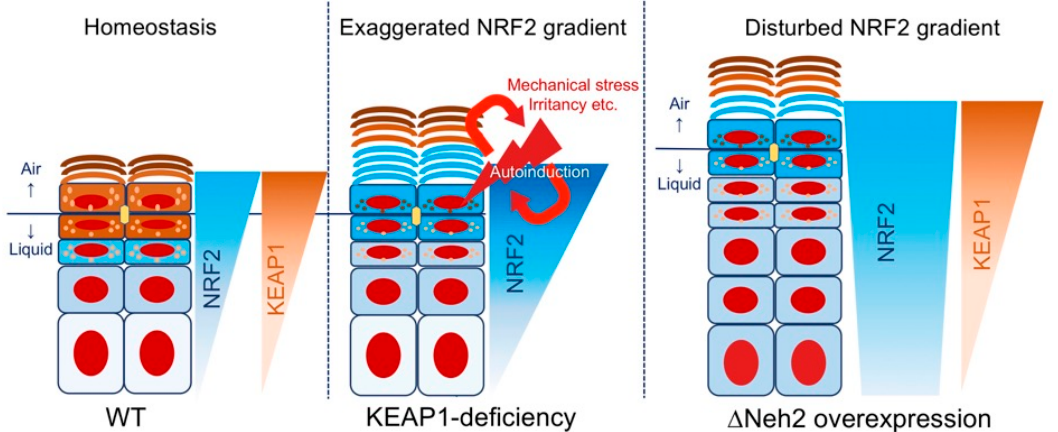
Figure 5. Why are Keap1 deficiency and Neh2 deficiency phenotypically different? Left: As with phase I detoxification, epidermal keratinocytes exhibit an incremented expression pattern of the KEAP1/NRF2 system that correlates with the degree of terminal differentiation. Middle: Absence of KEAP1 not only exaggerates the NRF2 expression gradient but also makes keratinocytes susceptible to cytoskeletal dysregulation (non-specific stimuli). Right: The overexpressed NRF2 that lacks the Neh2 degron augments NRF2 signaling in the presence of the inhibitor KEAP1. The disturbance in graded expression pattern in the epidermis mimics pathological conditions, such as ARCI or MADISH.